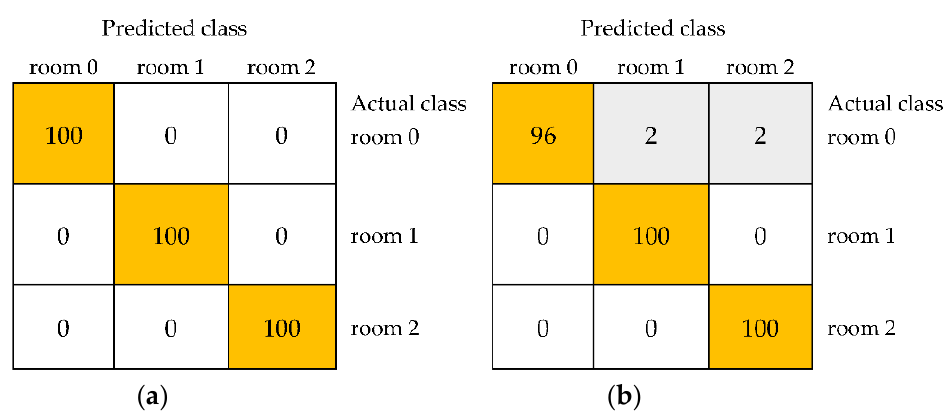
Table 1. The performance metrics of the classification of three classes of black currants (unstored, stored in the room for one week, and stored in the room for two weeks) based on models including selected image textures from color space RGB built using different algorithms.